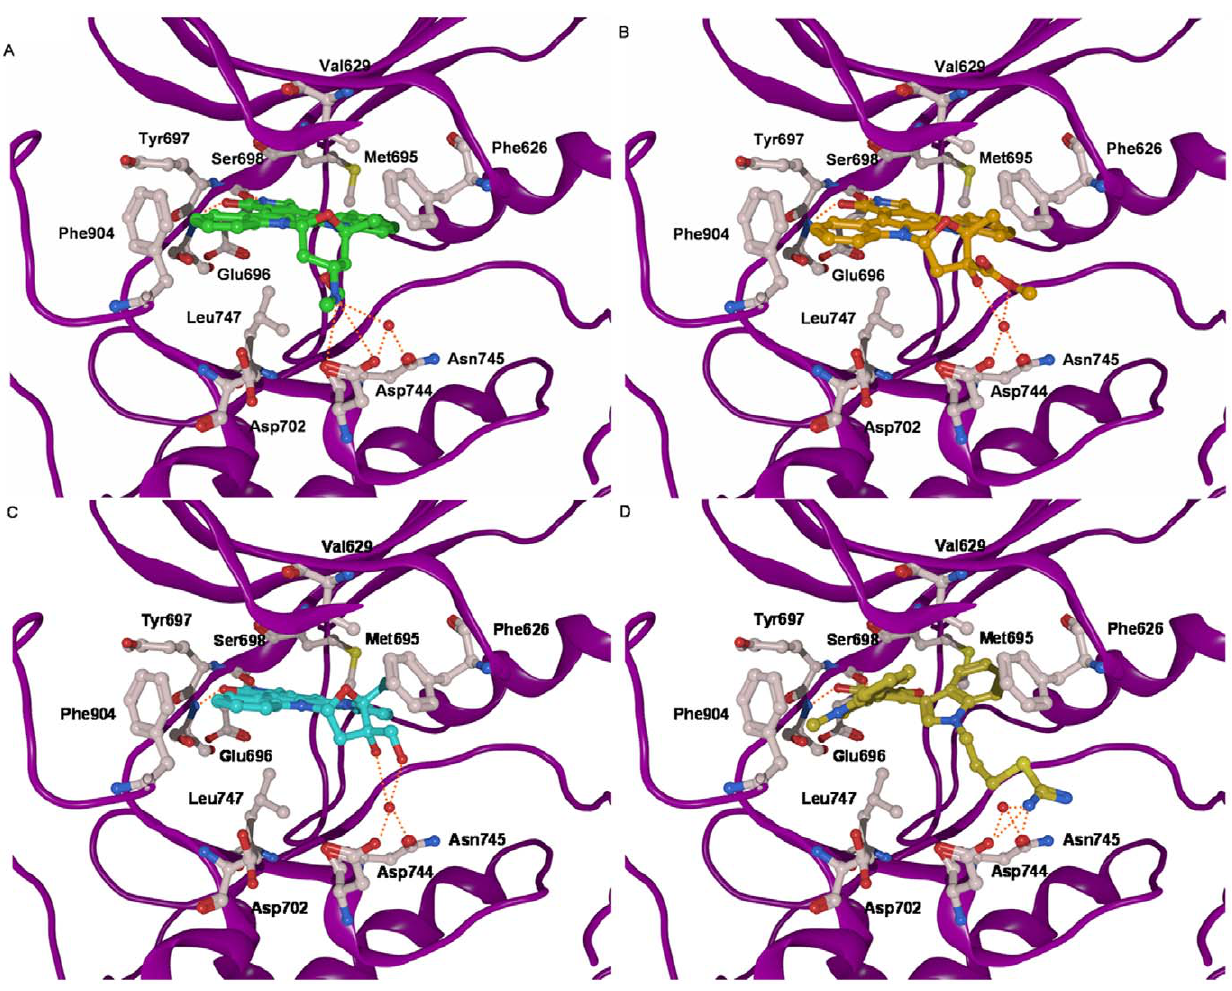
Figure 3. Details of the binding of ( A ) staurosporine (green), ( B ) K252a (orange), ( C ) lestaurtinib (cyan), and ( D ) Ro318220 (dark- yellow) to the PRK1 kinase domain. Common interactions of the inhibitors are hydrogen bonds involving Glu696 and Ser698 of the hinge region, and van-der-Waals interactions with the gatekeeper residue Met695, as well as with Val629, Phe626, Leu747, and Phe904. In addition, some of the inhibitors interact with Asp744, Asn745 and a conserved water molecule (red sphere) nearby the Mg 2 + binding site of the kinase. The backbone is shown as a purple ribbon. Only relevant amino acids are displayed. Hydrogen bonds are shown as dashed orange colored lines.